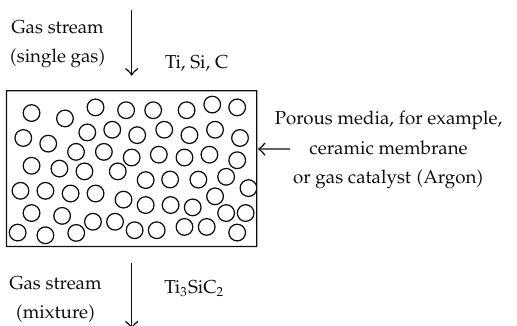
Figure 1: Chamber of the CVD